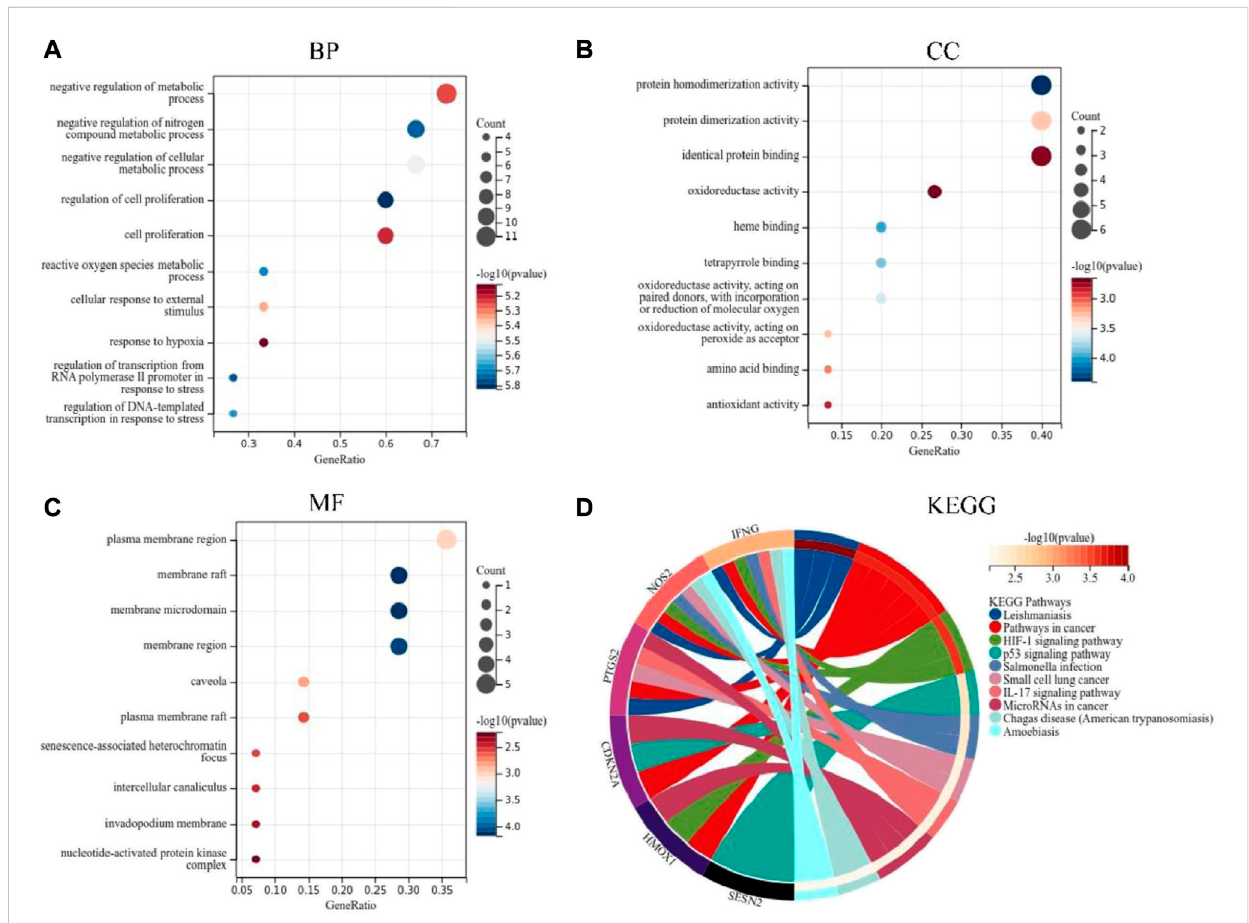
FIGURE 3 GO and KEGG pathway enrichment analyses of DEFRGs. (A) Top 10 GO (gene ontology) biological processes pathway. (B) Top 10 GO cellular component pathway. (C) Top 10 GO molecular function pathway. (D) Top 10 KEGG